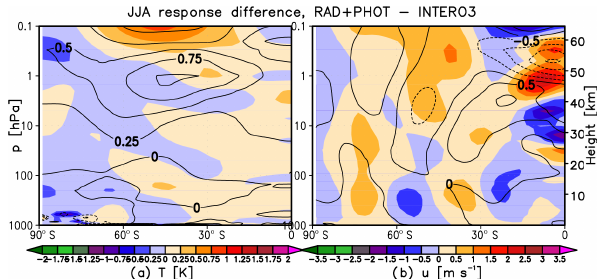
Figure 5. (a) Shading shows the JJA mean difference between the sum of the RAD-ONLY and PHOT-ONLY temperature (K) re- sponses and INTERO3. (b) As in (a) but for the corresponding dif- ference in zonal wind (ms − 1 ) responses. Contours in (a, b) show the responses in INTERO3 for